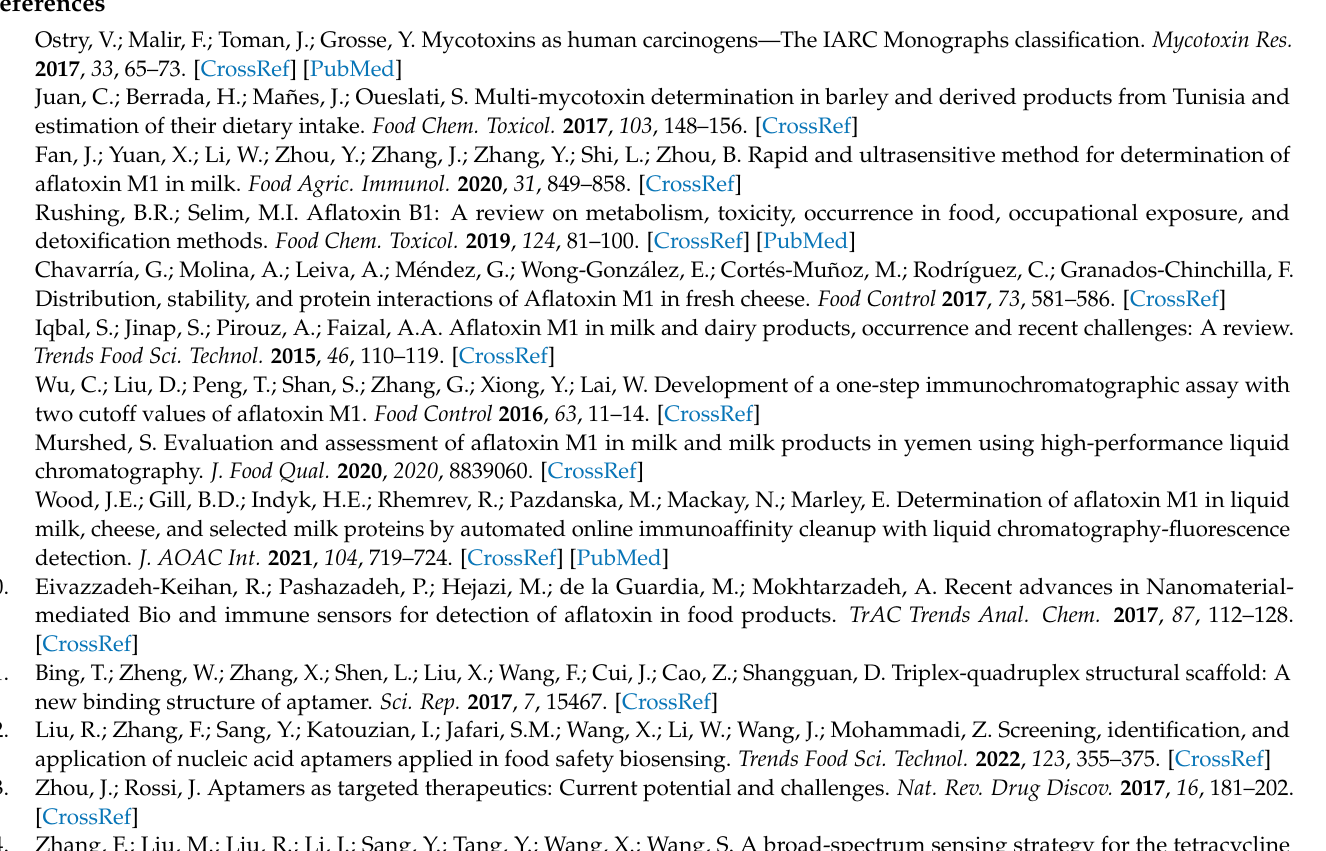
Figure S2: Optimization of the binding affinity conditions; Figure S3: Affinity nonlinear fitting curve of 24 aptamers; Figure S4: UV absorption curve (A) and TEM (B) of AuNPs; Figure S5: Detection curve developed in the milk